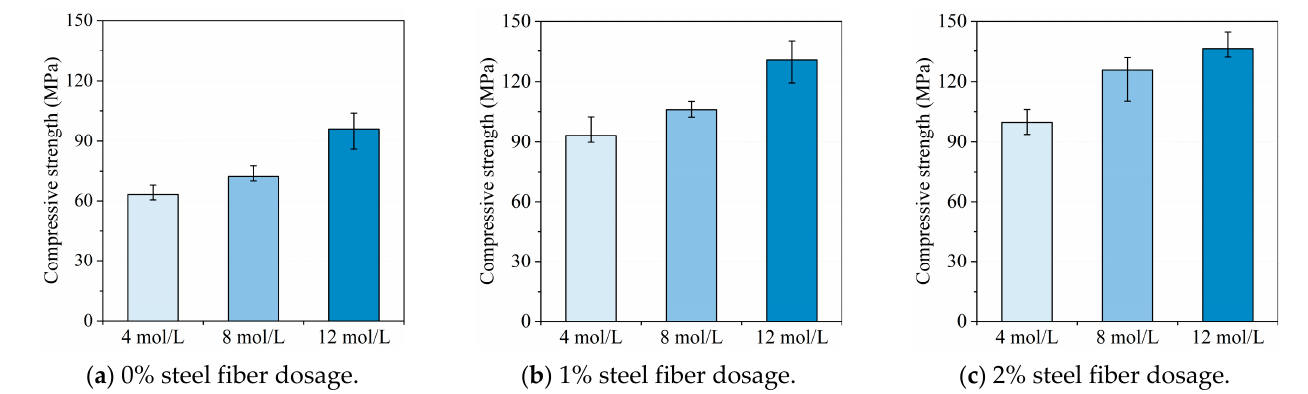
Figure 6. The influence of NaOH solution concentration on compressive strength.